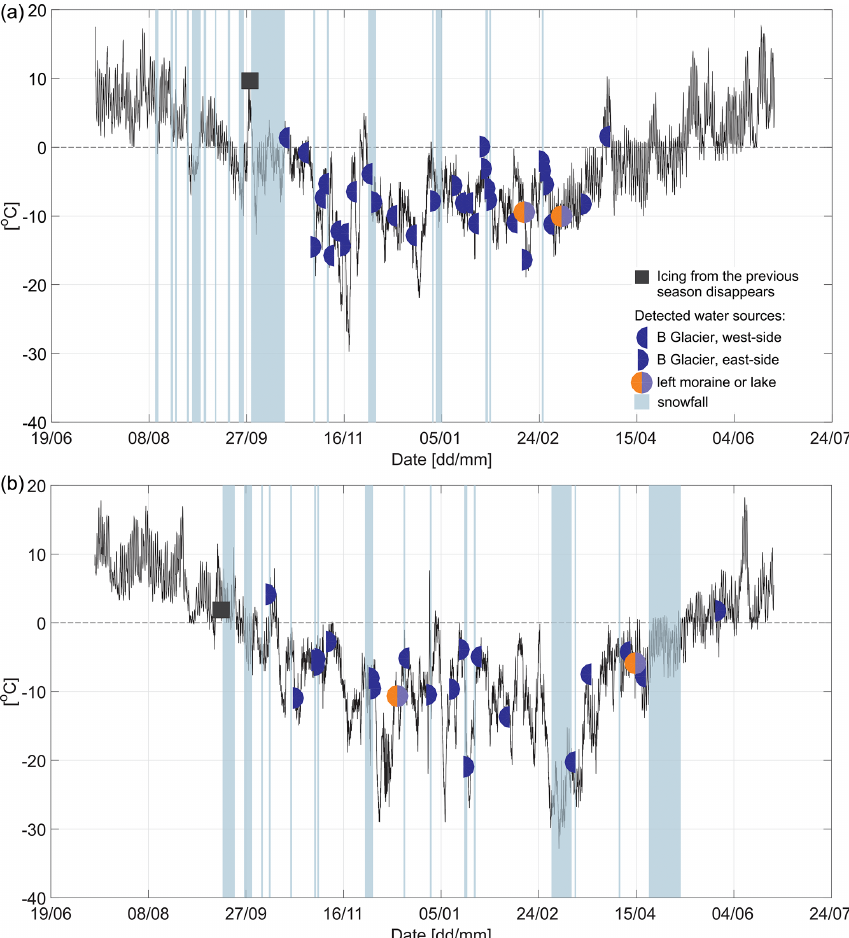
Figure 4. Hydrological activities observed in Watershed B by the use of time-lapse cameras for the 2015–2016 season (a) and the 2016–2017 season (b) . Solid black lines show air temperature measured at the automatic weather station, half-circles mark the timing of hydrological activity on either the left or right side of the proglacial field, and full circles represent the timing of hydrological activity related to either an ice-cored moraine or a moraine